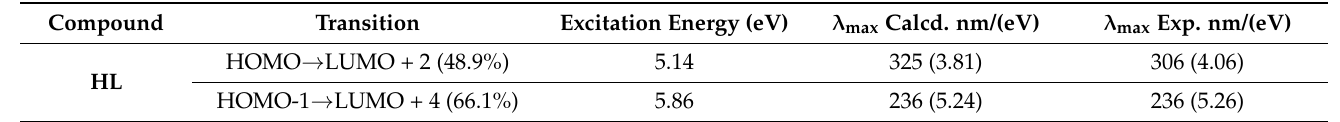
Table 4. Main UV-calculated optical transitions with composite ion in terms of molecular orbitals of free